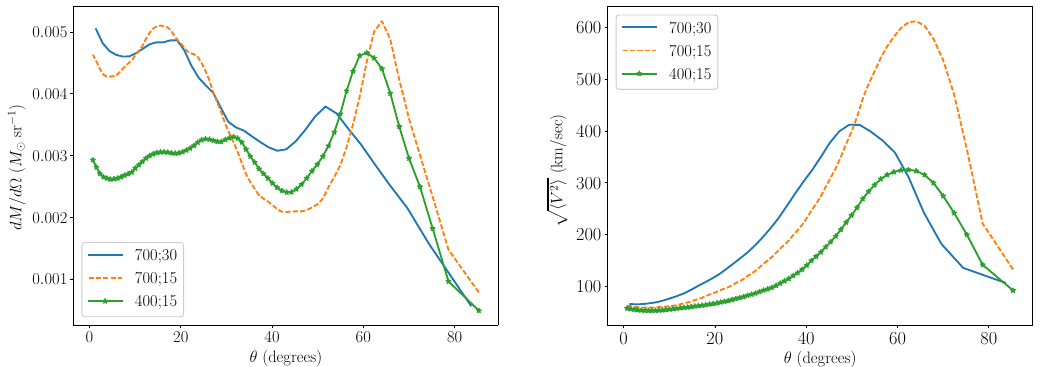
Figure 1. Left panel : The mass lost from the grid per unit solid angle as a function of the angle from the equatorial plane, for three different simulations of the onset of the grazing envelope evolution. The secondary star launches jets while it circles the asymptotic giant branch star on its equator in a Keplerian orbit with a period of 198.4 days. The simulations stop after 1620 days. The three first digits in the legend represent the jets velocity in kilometres per second while the two last digits represent the jets half-opening angle in degrees. The equator is at θ = 0 and the poles are at θ = 90. Simulation 700; 30 is from [26]. The amount of mass lost is that from the two hemispheres combined. In all three cases, the jets inject mass at a rate of ˙ M j = 0.001 M year − 1 . Right panel : The average speed of the (cid:12) outflow as a function of the angle from the equatorial plane of these three